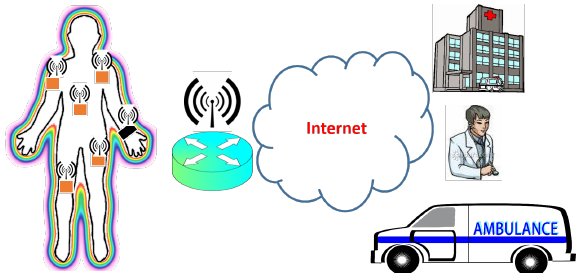
Figure 2. e/m-health system using IoT and wearable